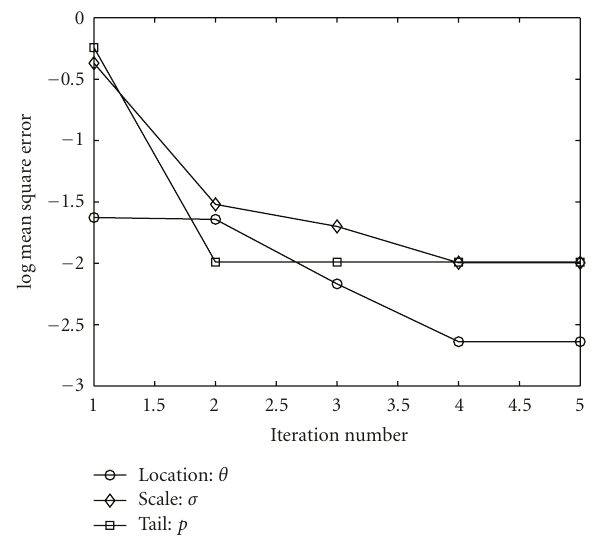
Figure 3: Multiparameter estimation MSE iteration evolution for a GCD process with ( θ , σ , P ) = (0, 1, 1 .